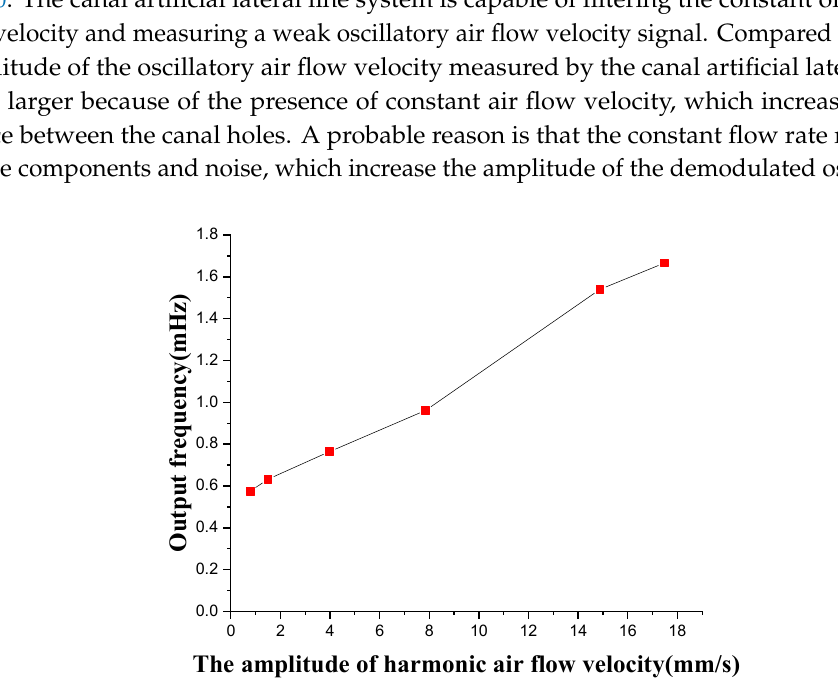
Figure 20. Output frequency signal of canal flow velocity sensor at the superimposed constant and oscillatory air flow velocity.